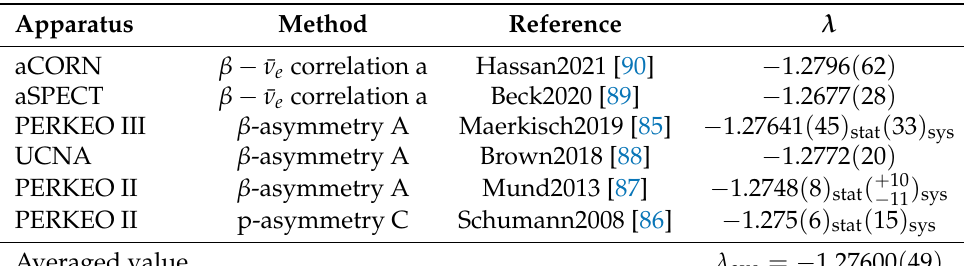
Table 2. List of adopted values of the ratio of the axial-to-vector couplings λ = g A / g V from exper- iments after 2002 using modern devices of aCORN, aSPECT, UCNA, PERKEO II, and PERKEO III [85–90] and their averaged value λ ave , which is different from the recommended value of PDG2022 [10]. Note that a scale factor employed in PDG2022 makes its error much larger due to the inclusion of many discrepant old data. Here only the aSPECT result shows a tension at the 2.9 σ level with the rest and hence we do not apply any additional scale factor on the error of the average